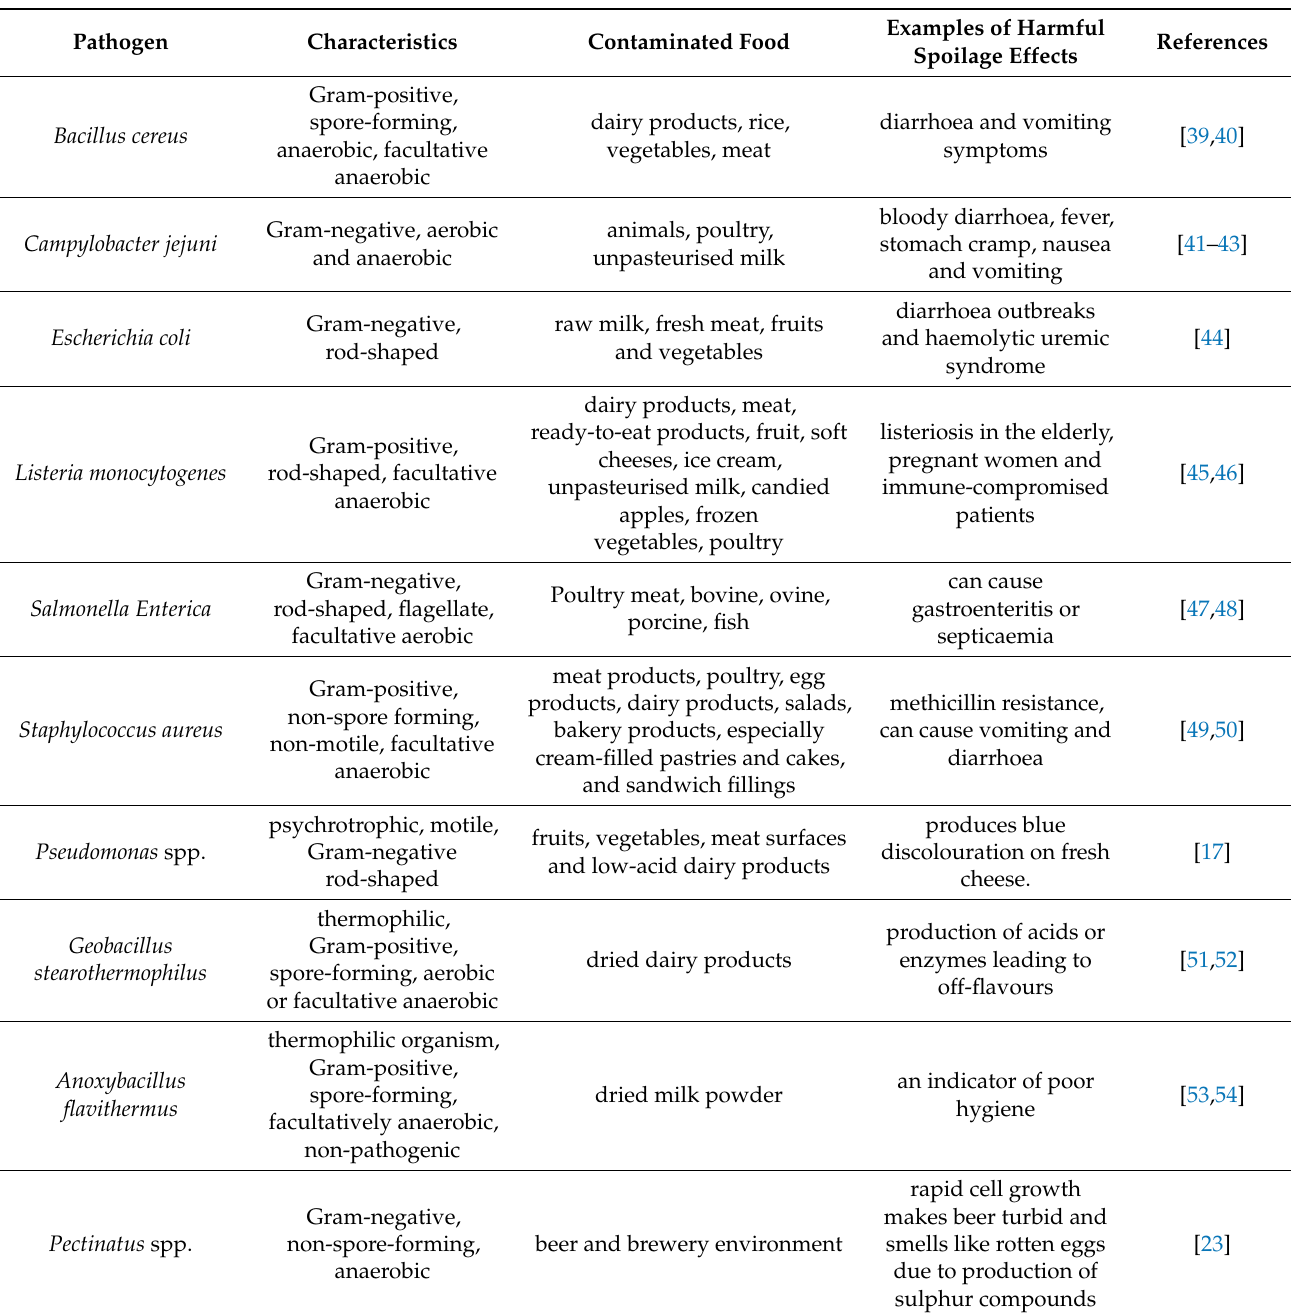
Table 1. Biofilm-forming pathogens in the food